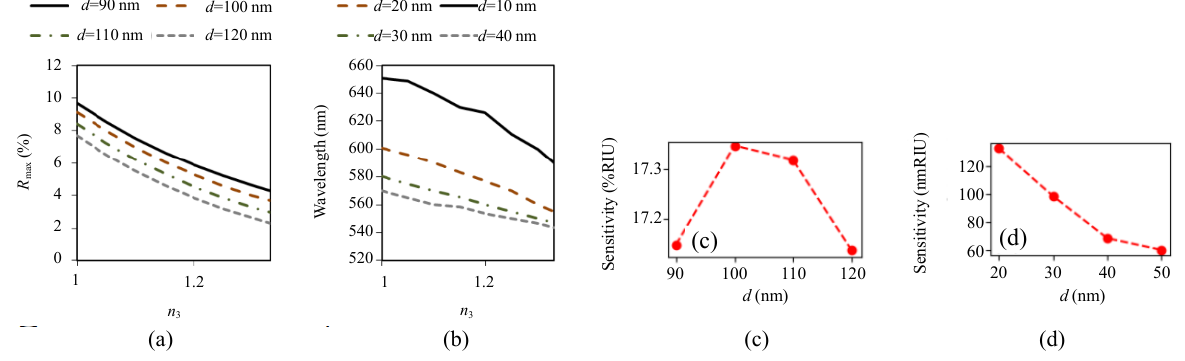
Fig. 4 Change of the (a) peak intensity for d > 90 nm and (b) peak wavelength for d < 40 nm for Au NPs in polymer when volume fraction f is set to be 0.055; (c) sensitivity for the peak intensity detection and (d) sensitivity for peak wavelength